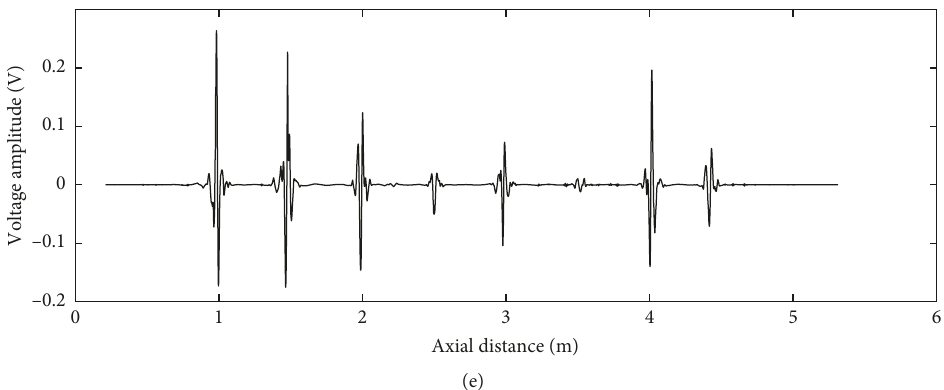
Figure 8: Signal after denoising by several algorithms. (a) Raw signal. (b) EWT algorithm. (c) HHT-WFCS algorithm. (d) EEMD- wavelet algorithm. (e) Proposed algorithm.